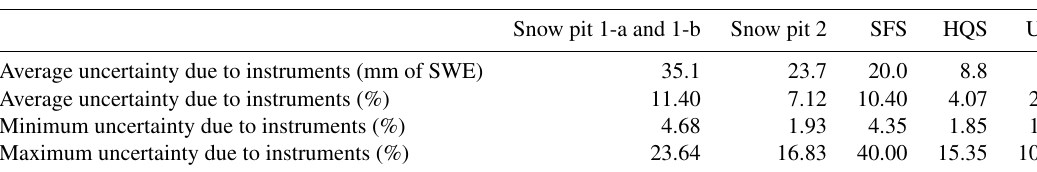
Table 3. Uncertainties due to instruments of the snow pit and snow samplers.